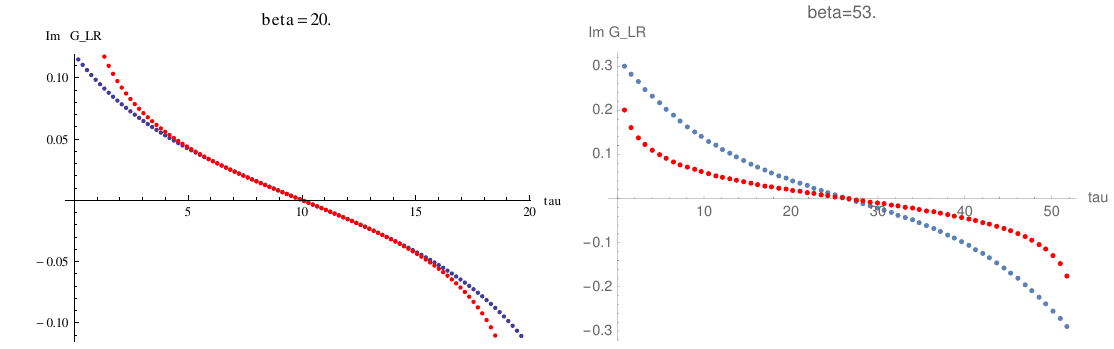
Figure 2 . Euclidean Green function G LR . The blue points correspond to the exact solution, and the red ones to the conformal answer (A.3). Left: β = 20 . Right: β = 53 . For this values of parameters the transition to the wormhole phase happens around β is better for higher